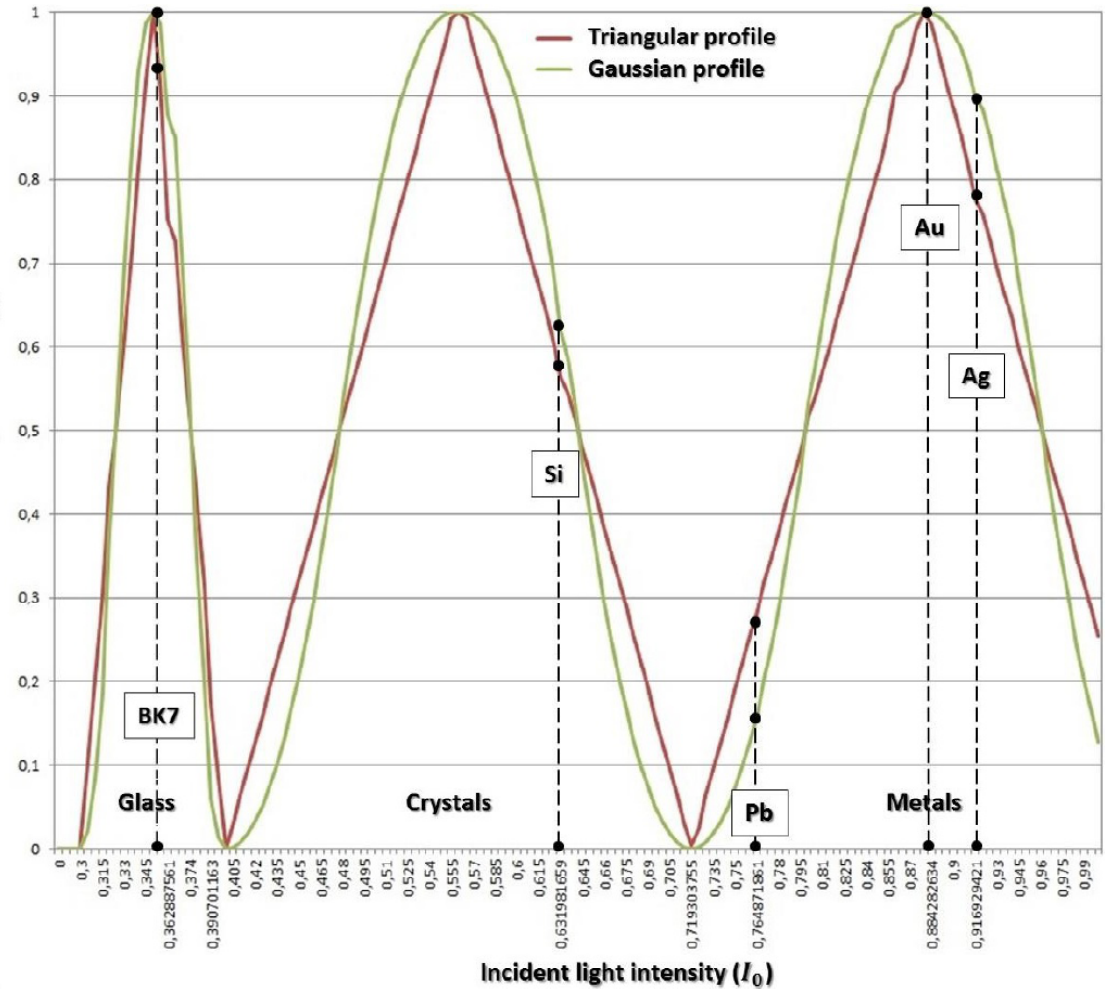
Fig. 5. Graph showing membership function by defined materials as glass, crystals, and metals versus incident light intensity on the